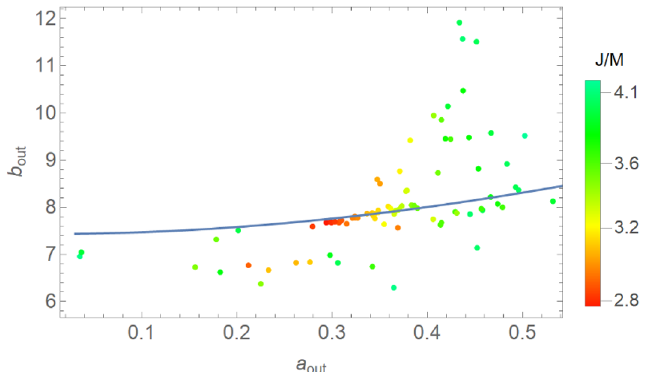
Figure 13 . Outgoing parameters ( a out ; b out ) for the collisions in (cid:12)gure 9 (dots), and for the geometric estimate (3.24) (blue